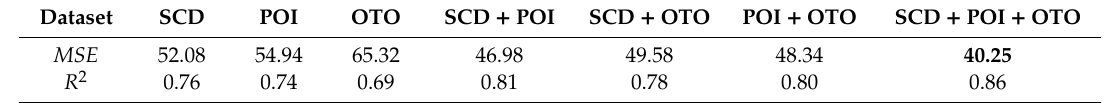
Table 3. Performance comparisons of the 7 train datasets.